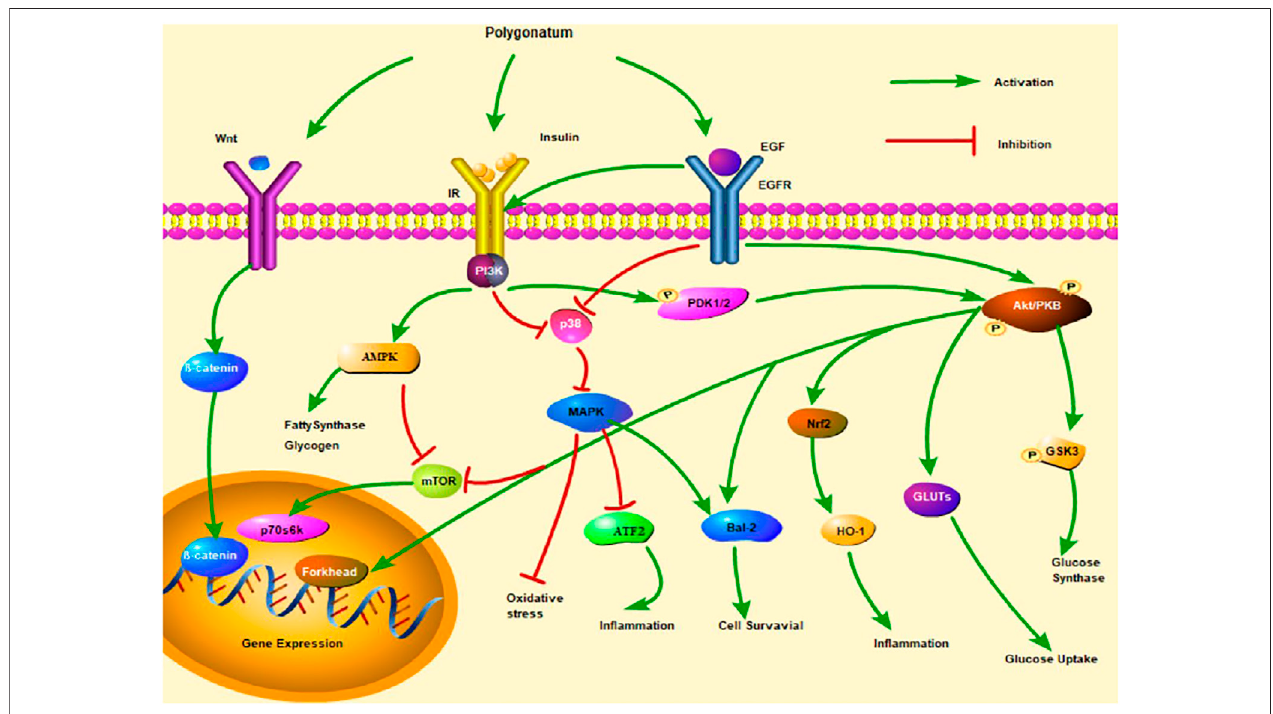
FIGURE 2 | Insulin signaling pathways of three Polygonatum spp. Note. mTOR, mammalian target of rapamycin; PDK1/2, 3-phosphoinositide-dependent protein kinase-1/2; GSK3, glycogen synthase kinase 3 β .